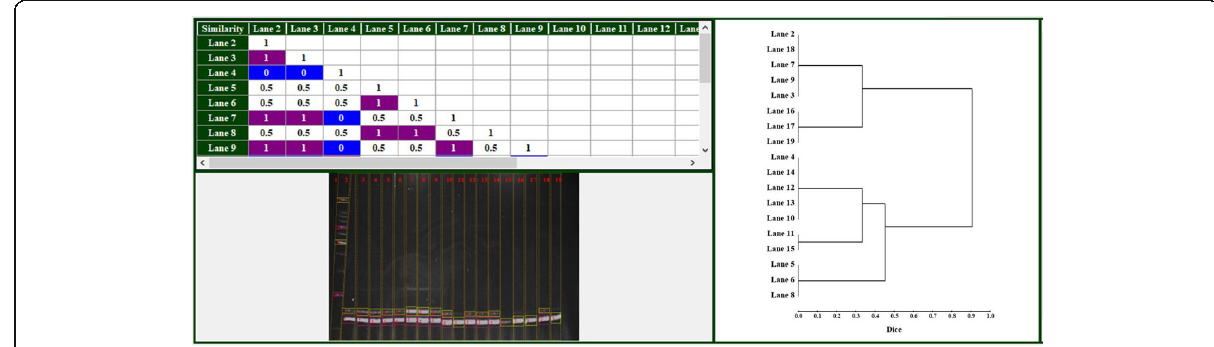
Fig. 2 A part of the image analysis section of the program showing the analyzed image (bottom left), the phylogenetic tree (right), and the similarity percentages (top left) with blue and purple shading for the lowest and highest similarity percentages,